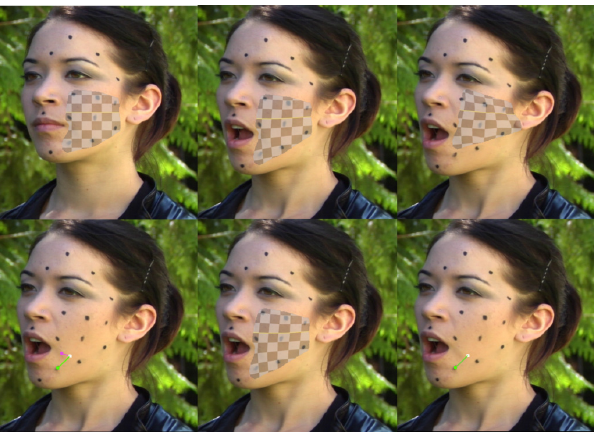
Fig. 6 Correcting tracking errors caused by large displacements. Top left to bottom right: part of reference frame 1 with tracking region marked, frame 12 with tracking from reference still working, frame 13 with tracking directly from frame 1 failing, provision of a single correspondence as hint (green), correct tracking with additional hint, and estimated displacement vector for corrected point.